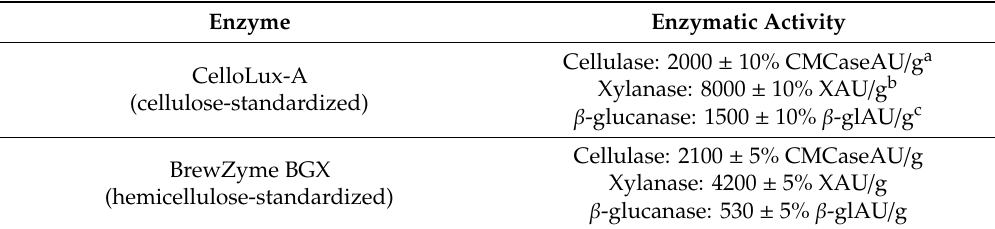
Table 1. Enzymes and their